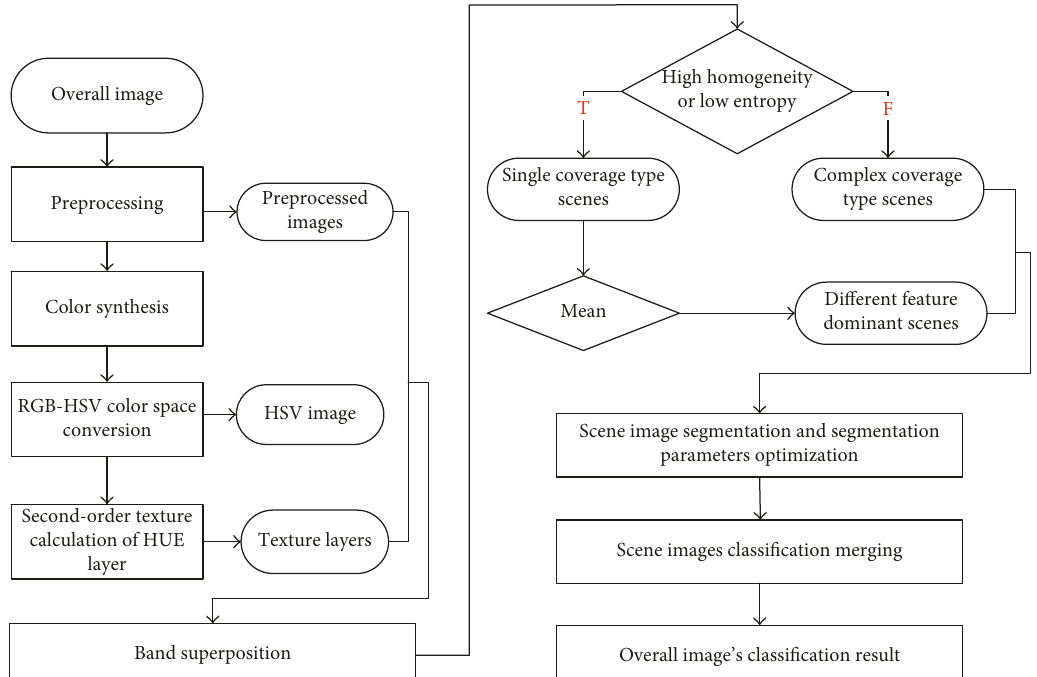
Figure 1: Workflow of stratified object-oriented image analysis based on remote sensing image scene